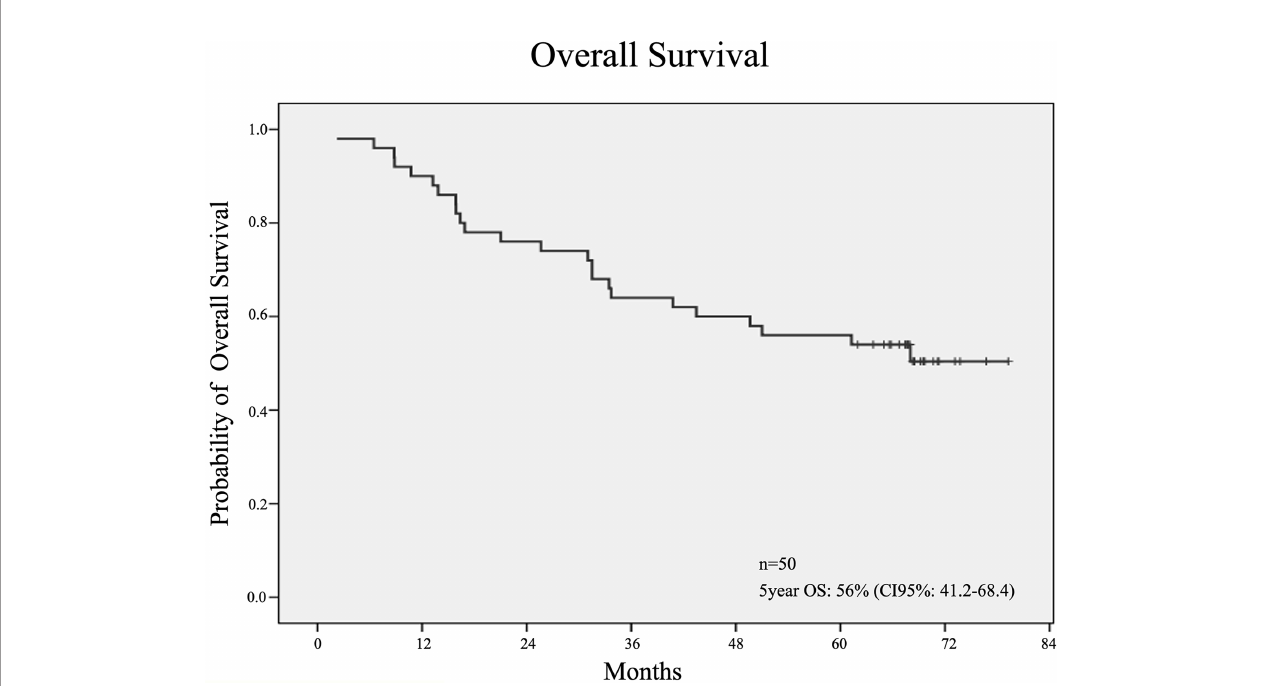
FIGURE 4 | Kaplan Meier curve for OS. n, number; OS, Overall Survival; CI, Con fi dence Interval.